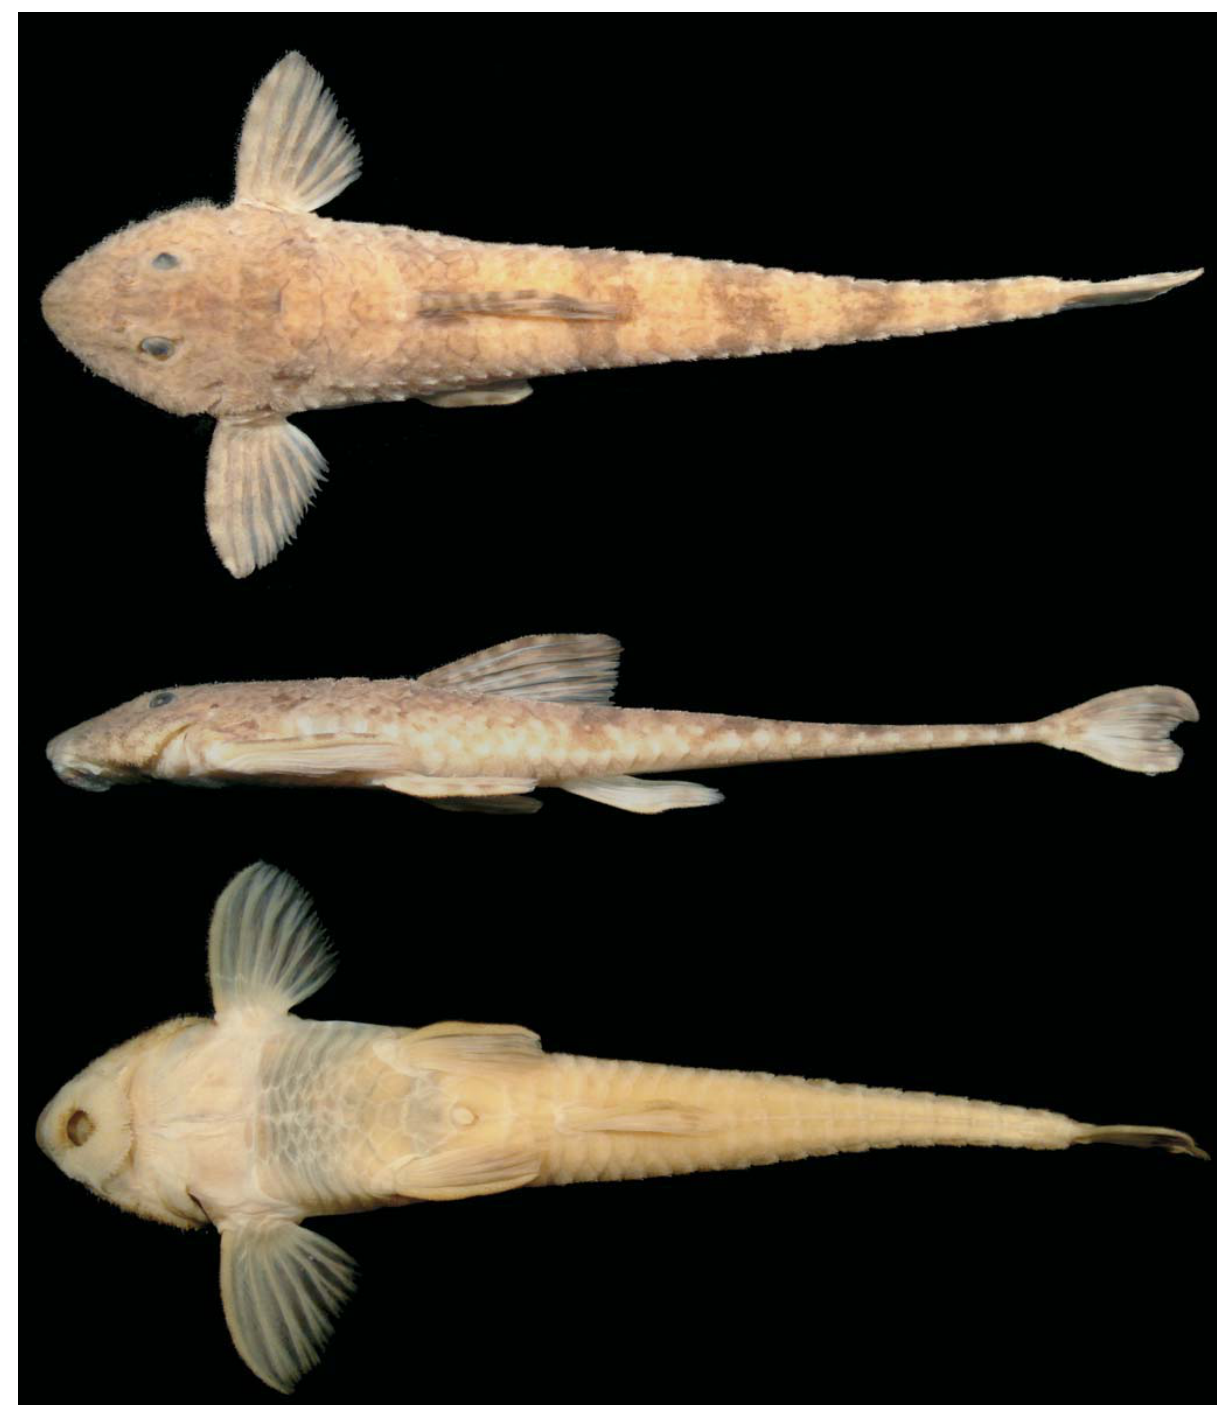
Fig. 3. Rineloricaria maacki , holotype, male, MNRJ 31158, 108.4 mm SL, rio Iguaçu, União da Vitória, Paraná,